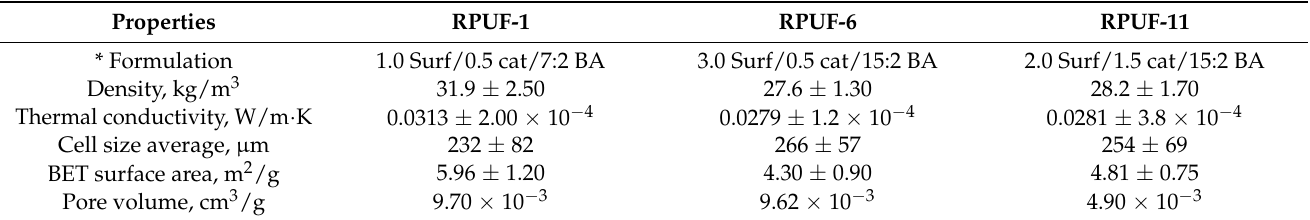
Table 4. Characteristics of the selected foams based on visual inspection.